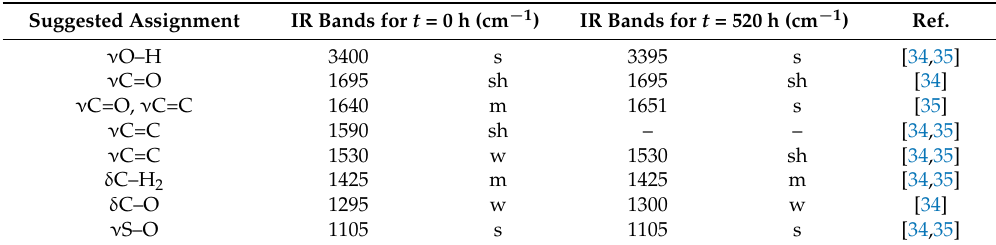
Table 2. Characteristic IR signals of ML detected at t = 0 h and at t = 520 h (s: strong; m: medium; w: weak; sh: